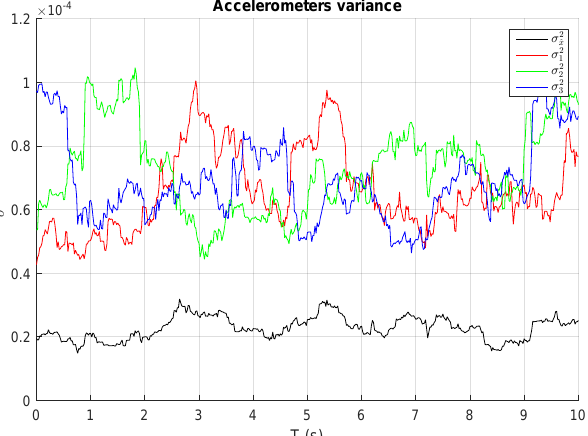
Figure 11. Individual measurement variances and sum block variances of three accelerometers in steady state with equal weighting factors.